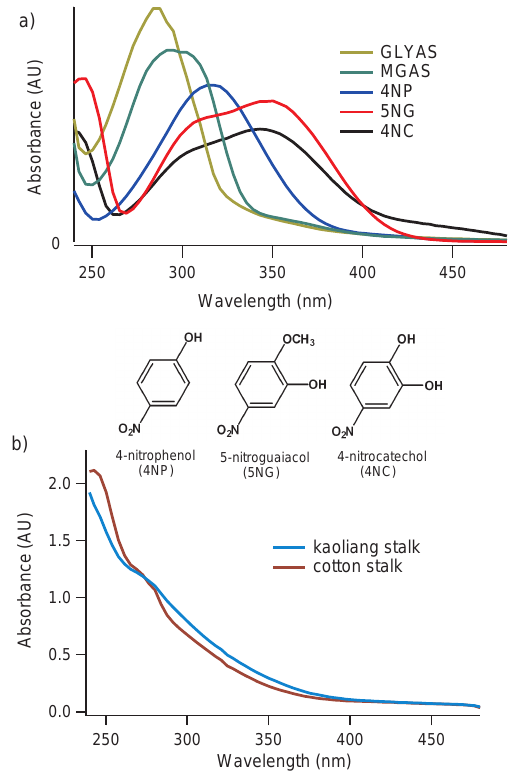
Figure 2. Absorption spectra of BrC investigated in this study (a) and WSOC from the biofuel combustion samples (b) . The y axis in (a) is in arbitrary units to keep the absorbance of all the solutions on